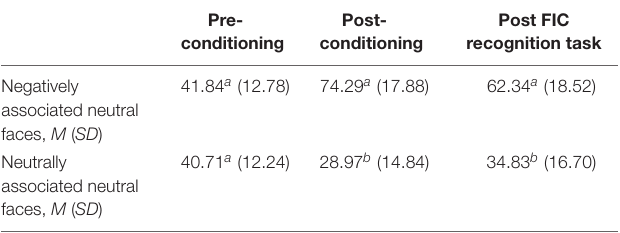
TABLE 3 | Means and standard deviations on experiential rating composite scores ( N = 67).